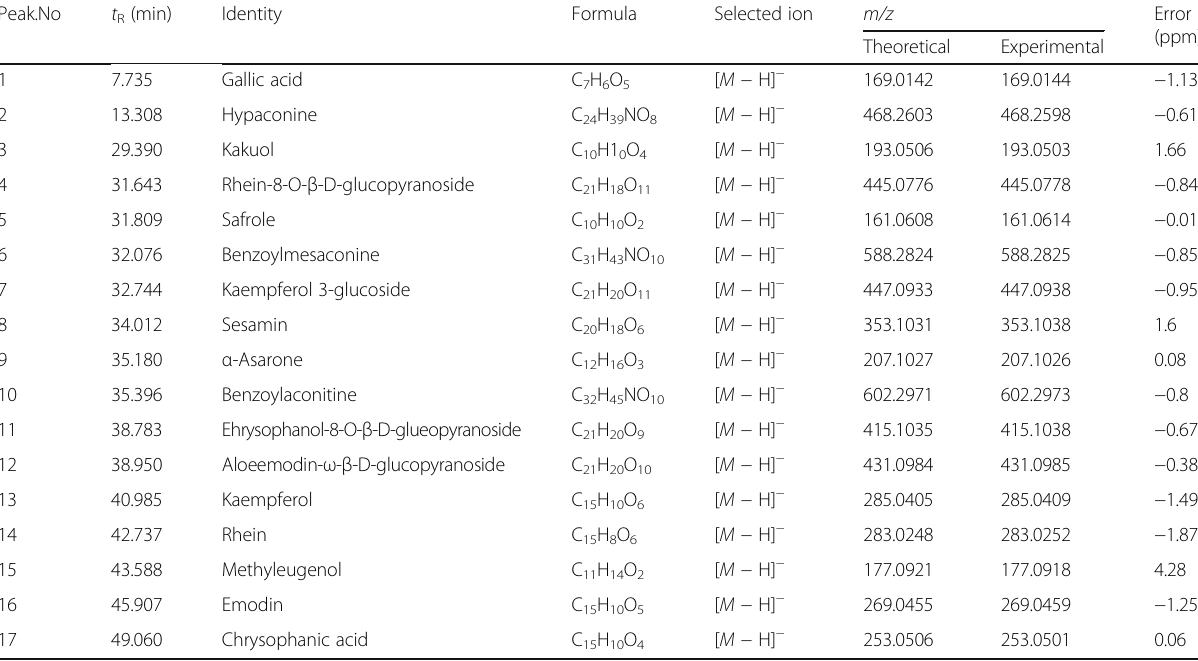
Table 3 Detection of Dai-Huang-Fu-Zi-Tang in negative ion mode Peak.No